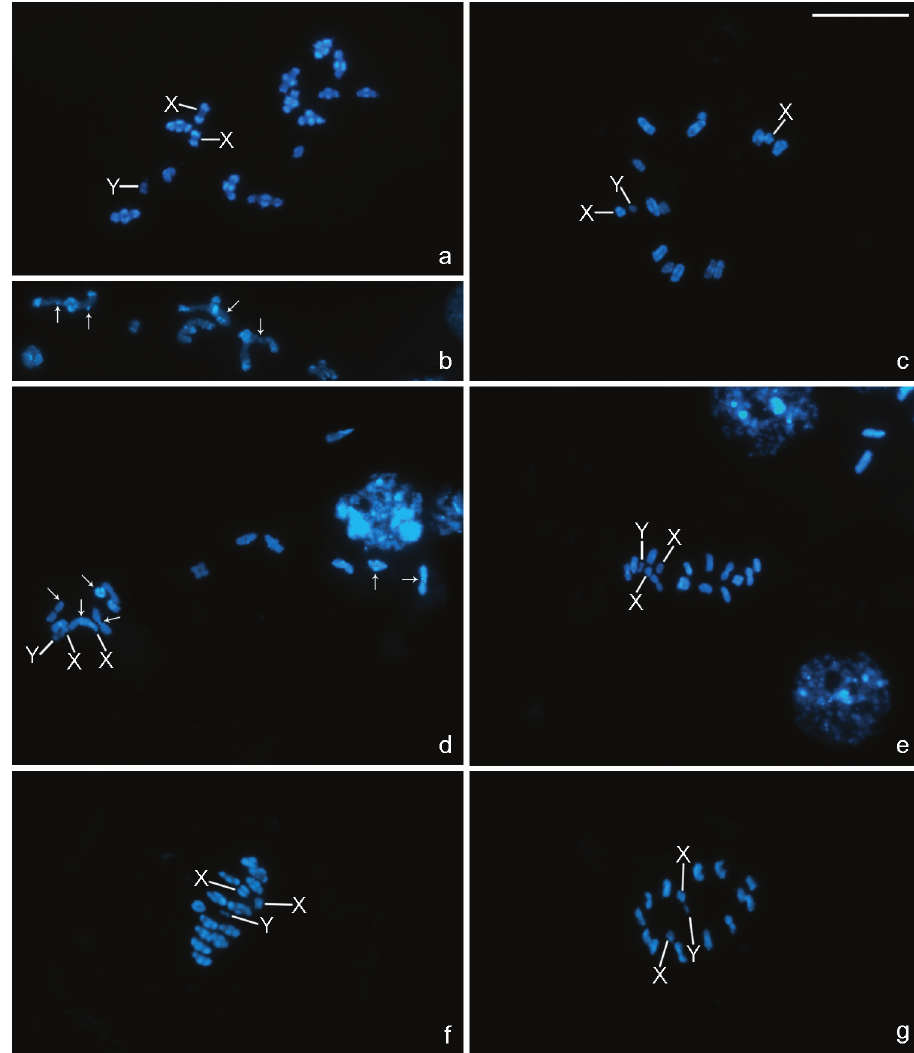
Figure 3. C-banding in chromosomes of B. elongatum ( a–c ), B. gestroi ( d, e ) and B. dentatum ( f, g ) stained with DAPI. a Diakinesis, conspicuous terminal C-positive blocks are observed in all autosomal bivalents and both X chromosomes b A detail of autosomal bivalents with interstitial C- positive dots (arrows) at early diakinesis c Late diakinesis d Diakinesis, small terminal C-positive bands in some autosomal bivalents (arrows) e Metaphase I f Late diakinesis, terminal C-positive bands in all autosomal bivalents and both X chromosomes g Metaphase II. a, c–g The Y chromosome is C-negative. X, Y = sex chromosomes. Bar = 10